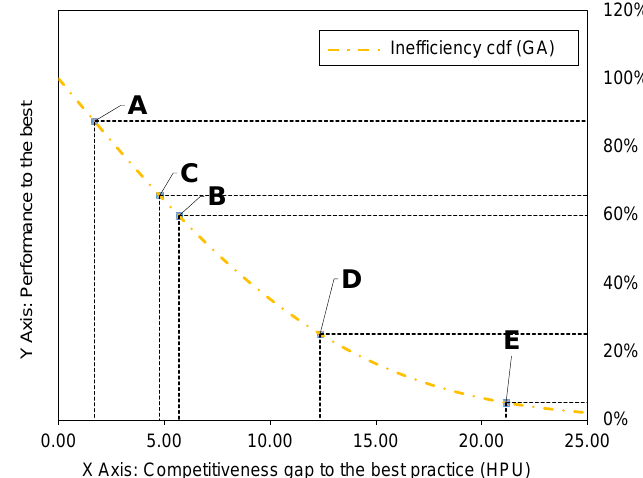
Figure 5. Assessment for